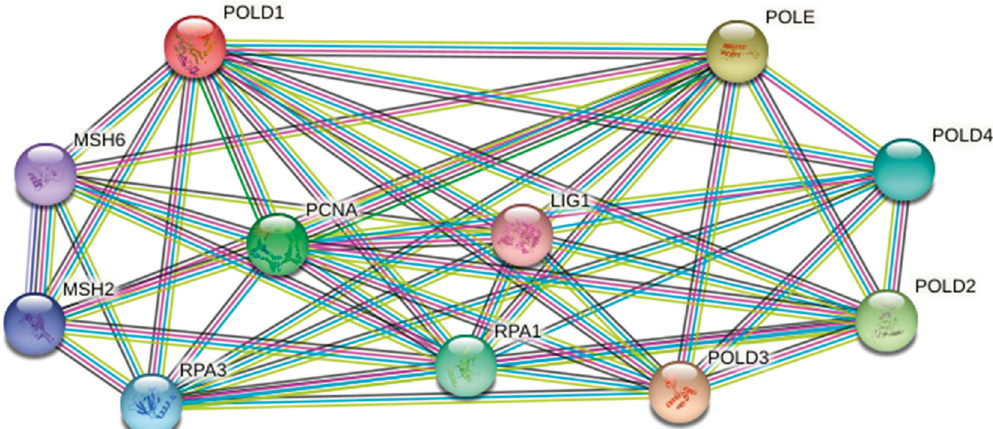
Figure 6: Intercome analysis of